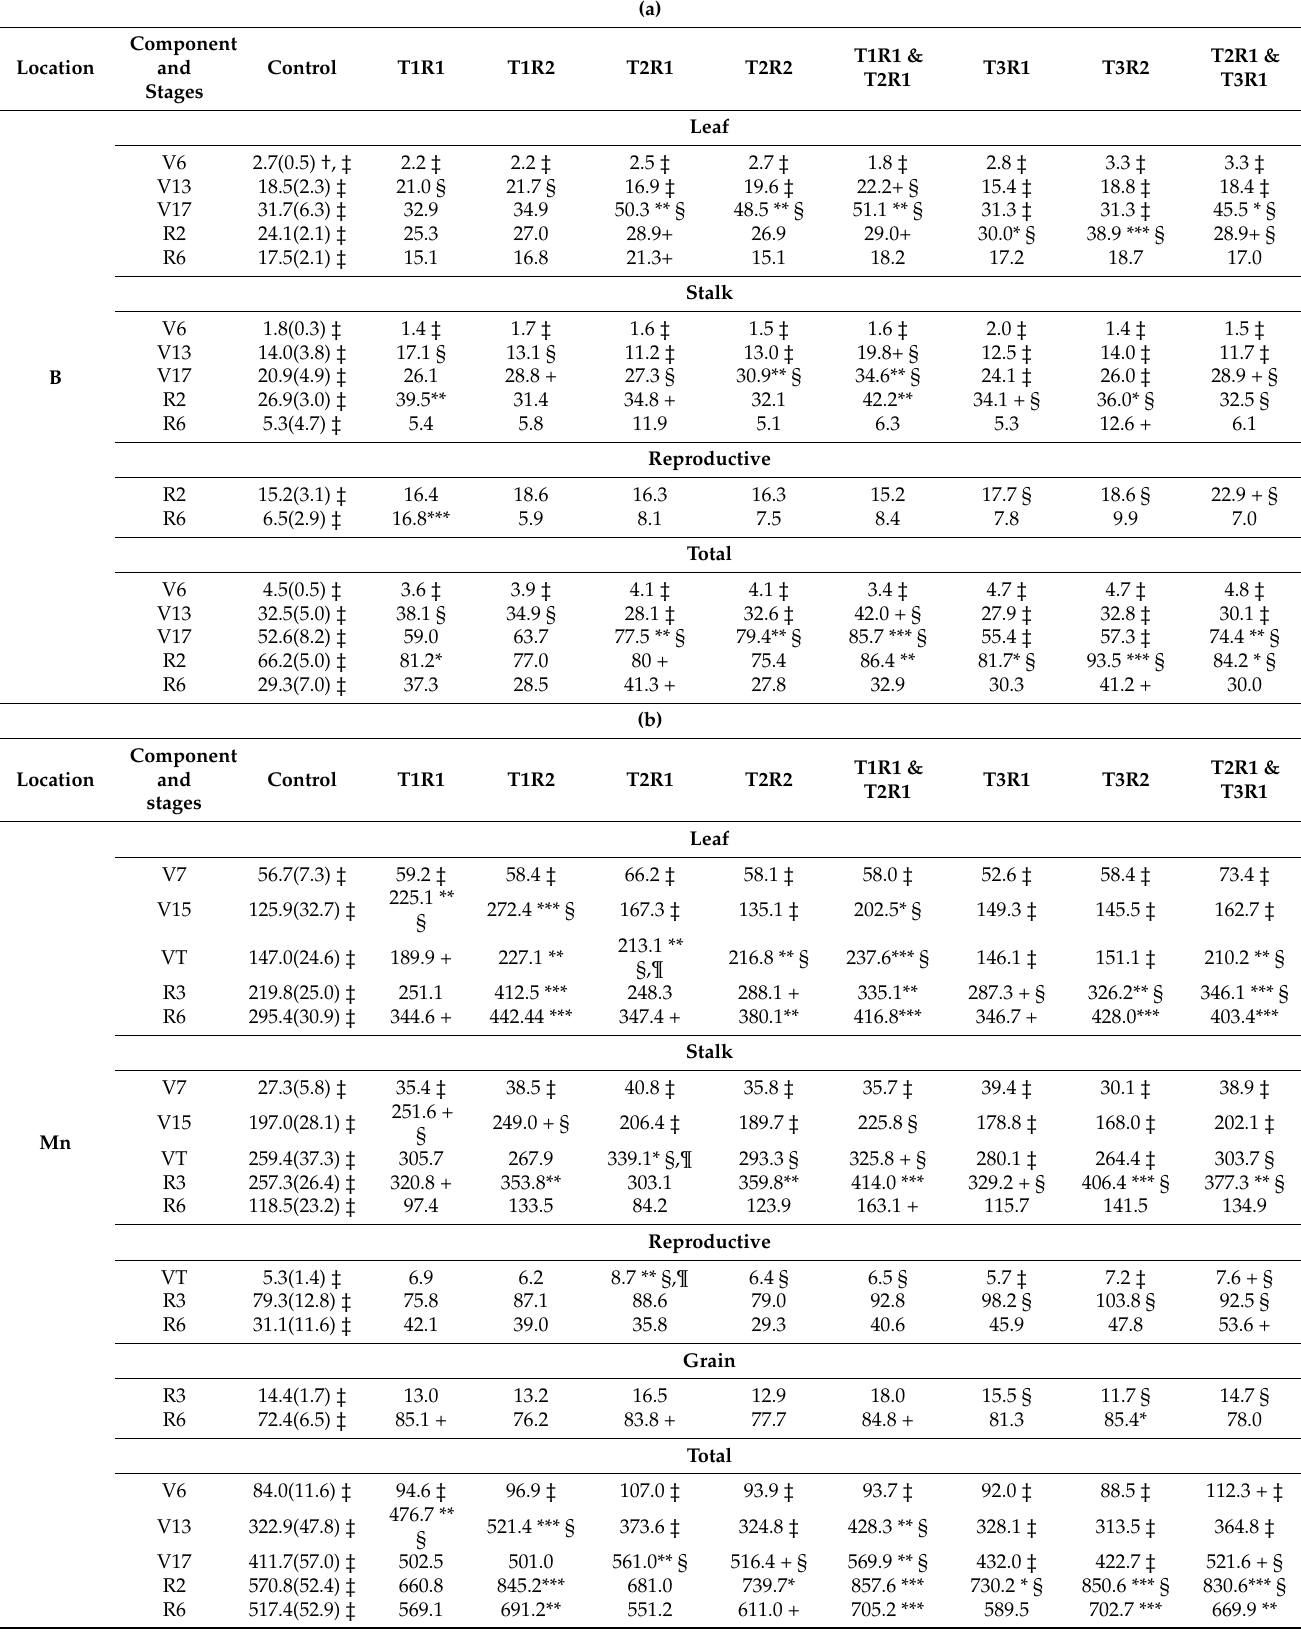
Table 5. ( a – e ). Multiple comparison test of LSmeans of nutrient quantity (g ha − 1 ) in partitioned plant tissues at various stages comparing treatment effects with